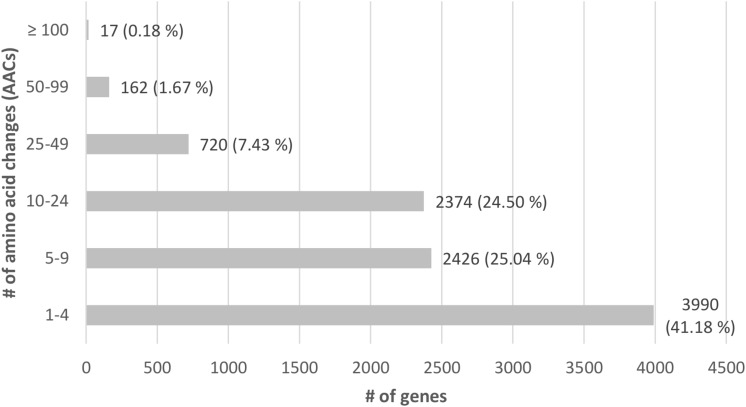
All genes with amino acid changes (AACs) after comparing MAD-SB12 and FPRL280, according to amount of AACs (y-axis) and number of genes with corresponding percentage (x-axis).